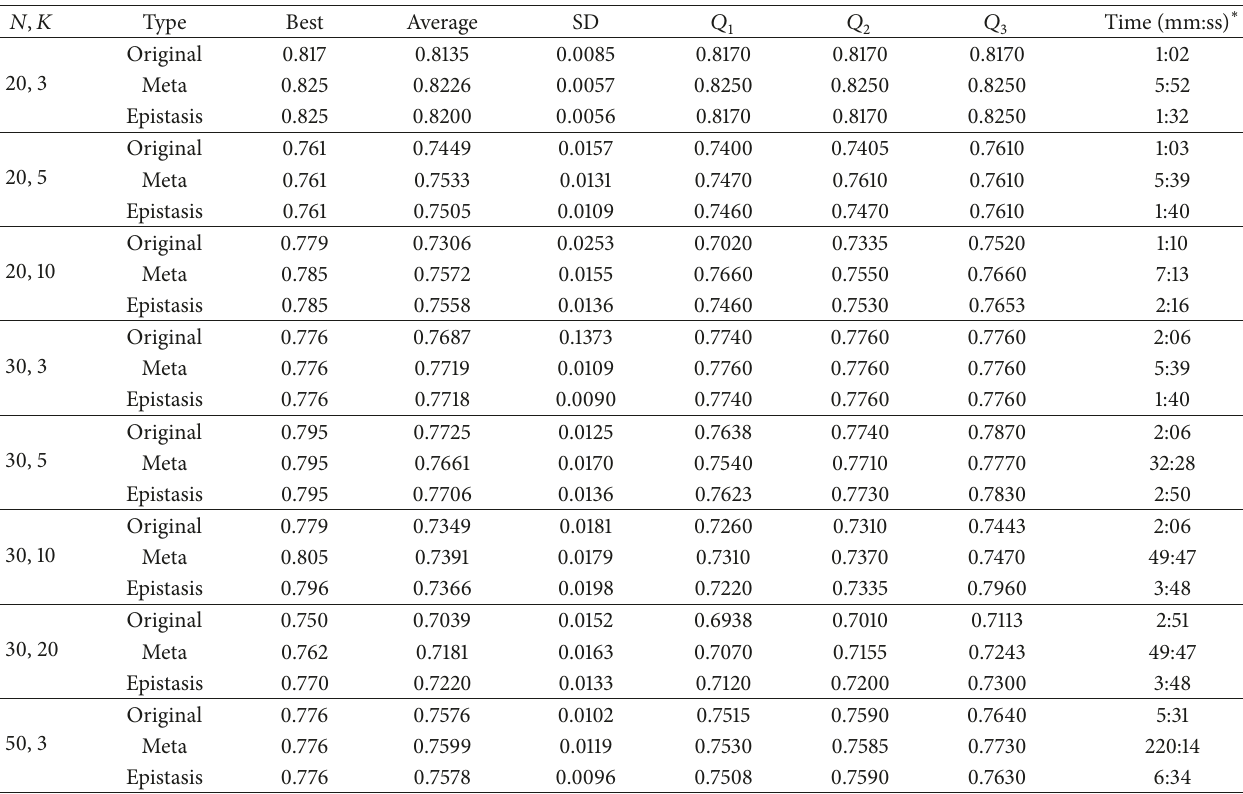
Table 4: Results of each of the best solutions obtained by conducting the GA experiments 100 times on an instance of the 𝑁𝐾 -landscape problem. (‘Best’ is the best fitness among solutions found in 100 experiments, ‘Average’ is the average of 100 best solutions, and ‘SD’ is the standard deviation of 100 best solutions. 𝑄 1 ,𝑄 2 , and 𝑄 3 are the first, second, and third quartiles, respectively. ‘Time’ is the sum of the time to search for the basis and that for the GA experiments.)